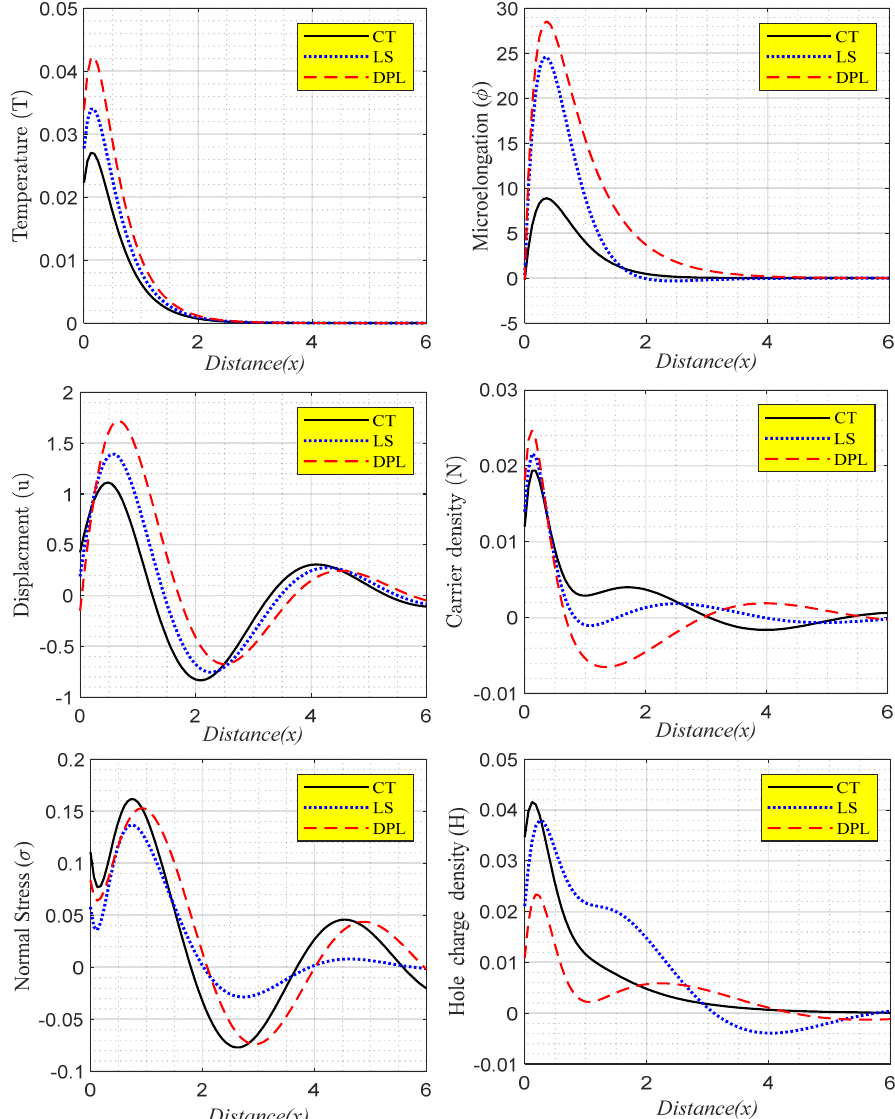
Figure 2. According to the two-temperature theory, the primary field distributions change with horizontal distance at various thermal memory (thermal relaxation durations) under the impact of laser pulses.